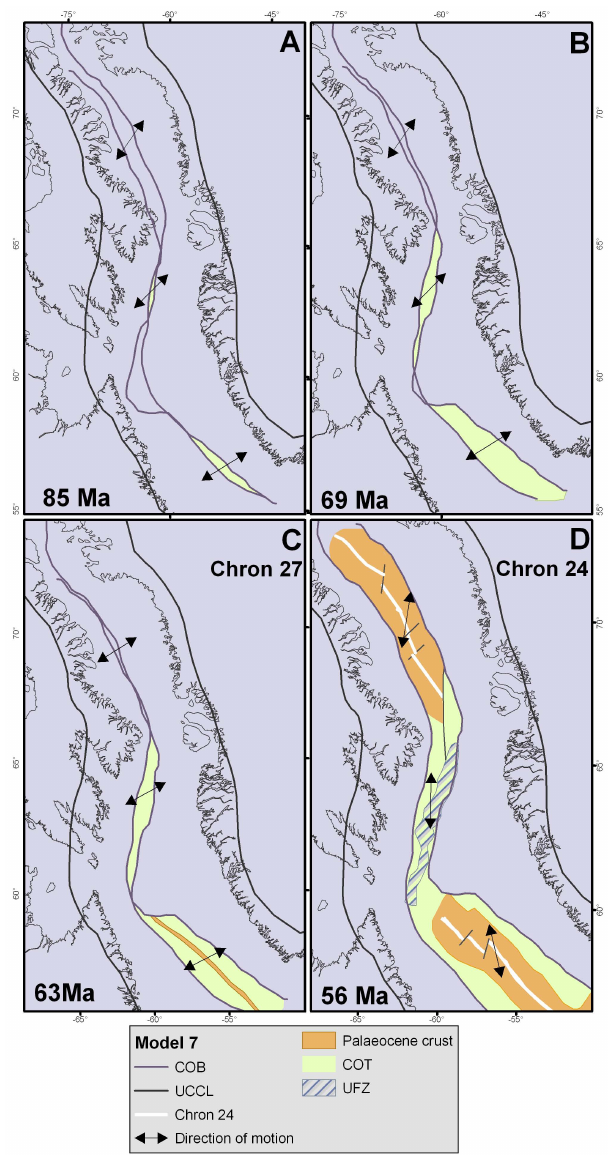
Fig. 15. Reconstruction of the rifting and seafloor spreading in the Labrador Sea and Baffin Bay. The models use the rotation pole from model 7 UCCL and COBs (purple lines) for the rifting period (120 up to 63Ma). Seafloor spreading (63Ma and younger) has been re- constructed using Oakey and Chalmers (2012) poles of